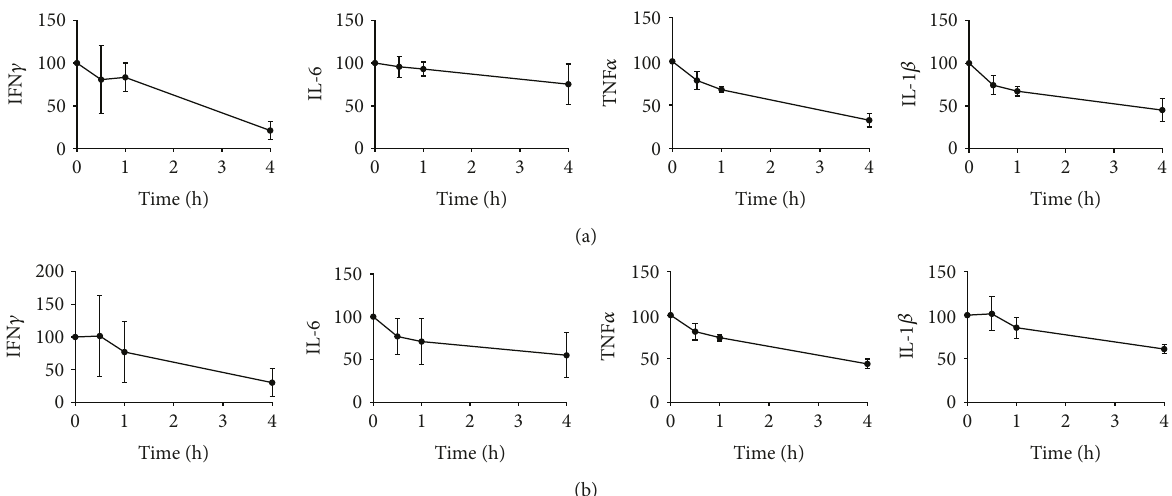
Figure 4: Cytokine release in whole blood culture supernatants; RPMI e ff ect (as % of the response at t = 0 , average plus SD). The whole blood of 3 donors was stimulated for 24 hours with LPS in the absence of RPMI (a) or diluted 1 :1 with RPMI during aging (b). The x -axis indicates the sample age (time span between blood collection and start incubation). The blood was stored at room temperature.